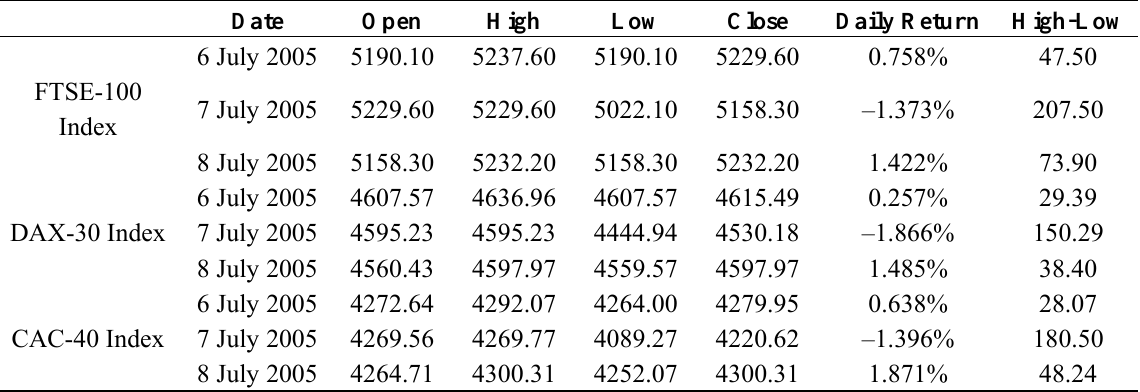
Table 1. Stock Prices ± one day of the event—Daily data